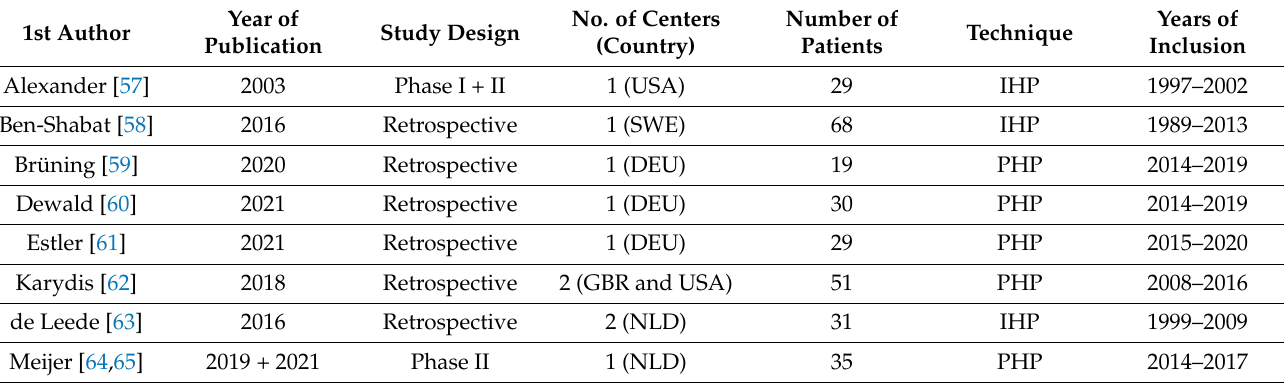
Table 1. Patient series characteristics.